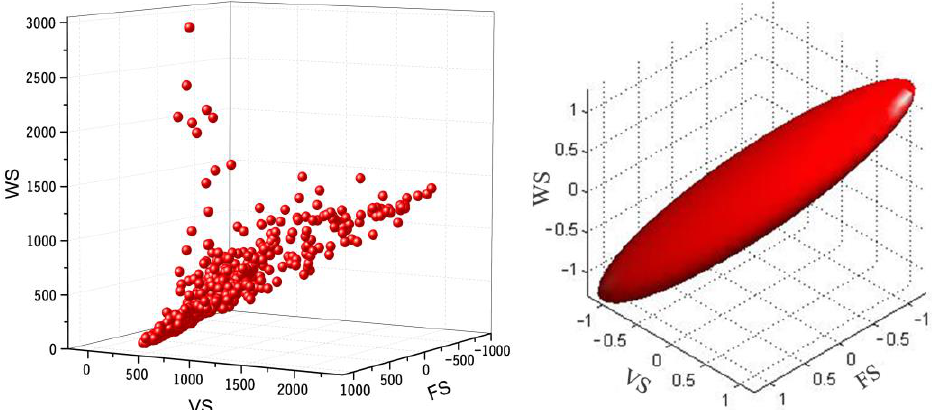
Table 4. Matrix representation of the ESST in the Manas River Basin.